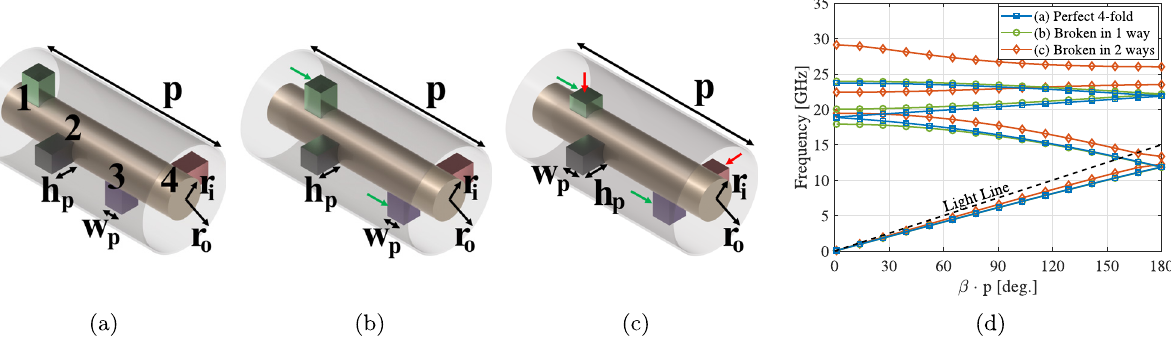
Fig. 4. Simulated structures for the observation of the symmetry breaking. Studied structures: (a) perfect 4-fold twist symmetry, (b) broken symmetry in 1 way, and (c) broken symmetry in two ways. (d) Dispersion diagram using the dimensions: h p =1.2 mm, w p =1 mm, r i = 1 mm, r o =2.5 mm, and p = 10 mm. The fi rst symmetry breaking is obtained by shifting pin 1 (green) and pin 3 (violet) by 1mm according to green arrows. The second breaking is obtained by reducing heights of pin 1 (green) and 4 (red) by 0.6 mm according to red